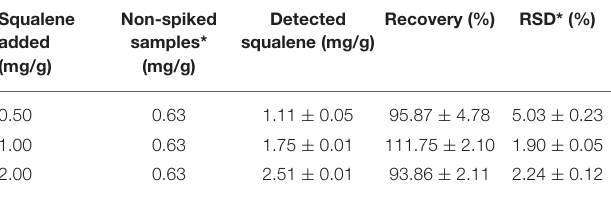
TABLE 4 | Results of recovery tests at three concentrations.